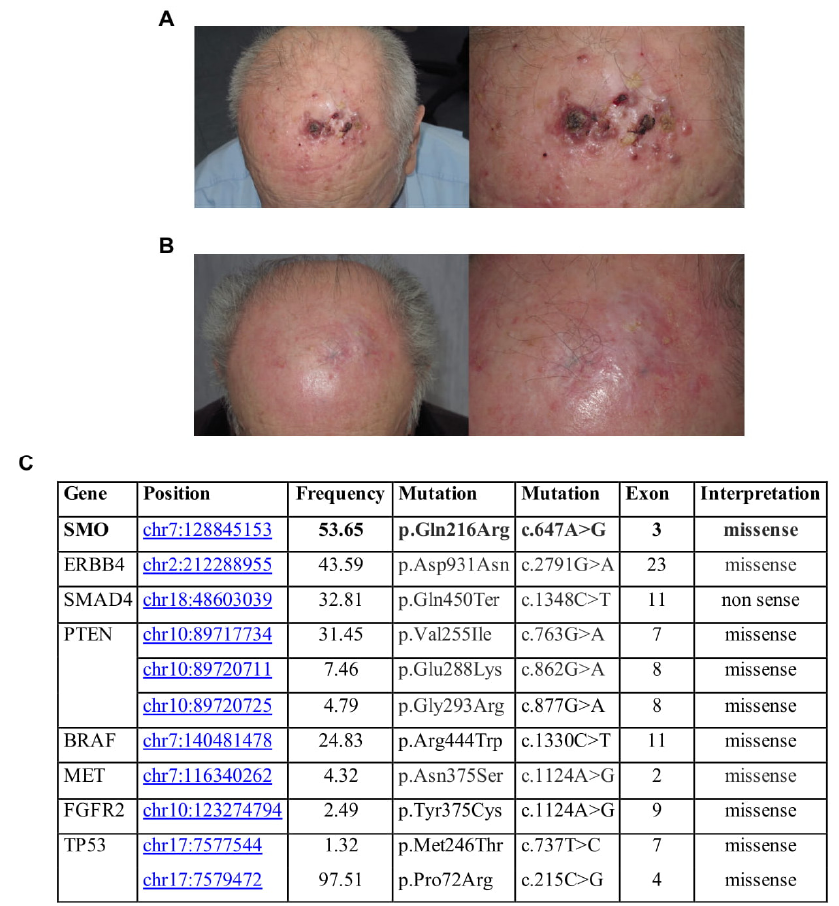
Figure 1. ( A ) Clinical presentation at time of diagnosis; ( B ) Clinical presentation after two months of imiquimod (IMQ) treatment; ( C ) Gene, mutation, frequency, and exon in this sample. A direct effect of IMQ on the oncogenic HH/SMO pathway in a basal cell carcinoma (BCC) has been reported recently [10]. Here, we transfected a melanoma cell line (MeWo)